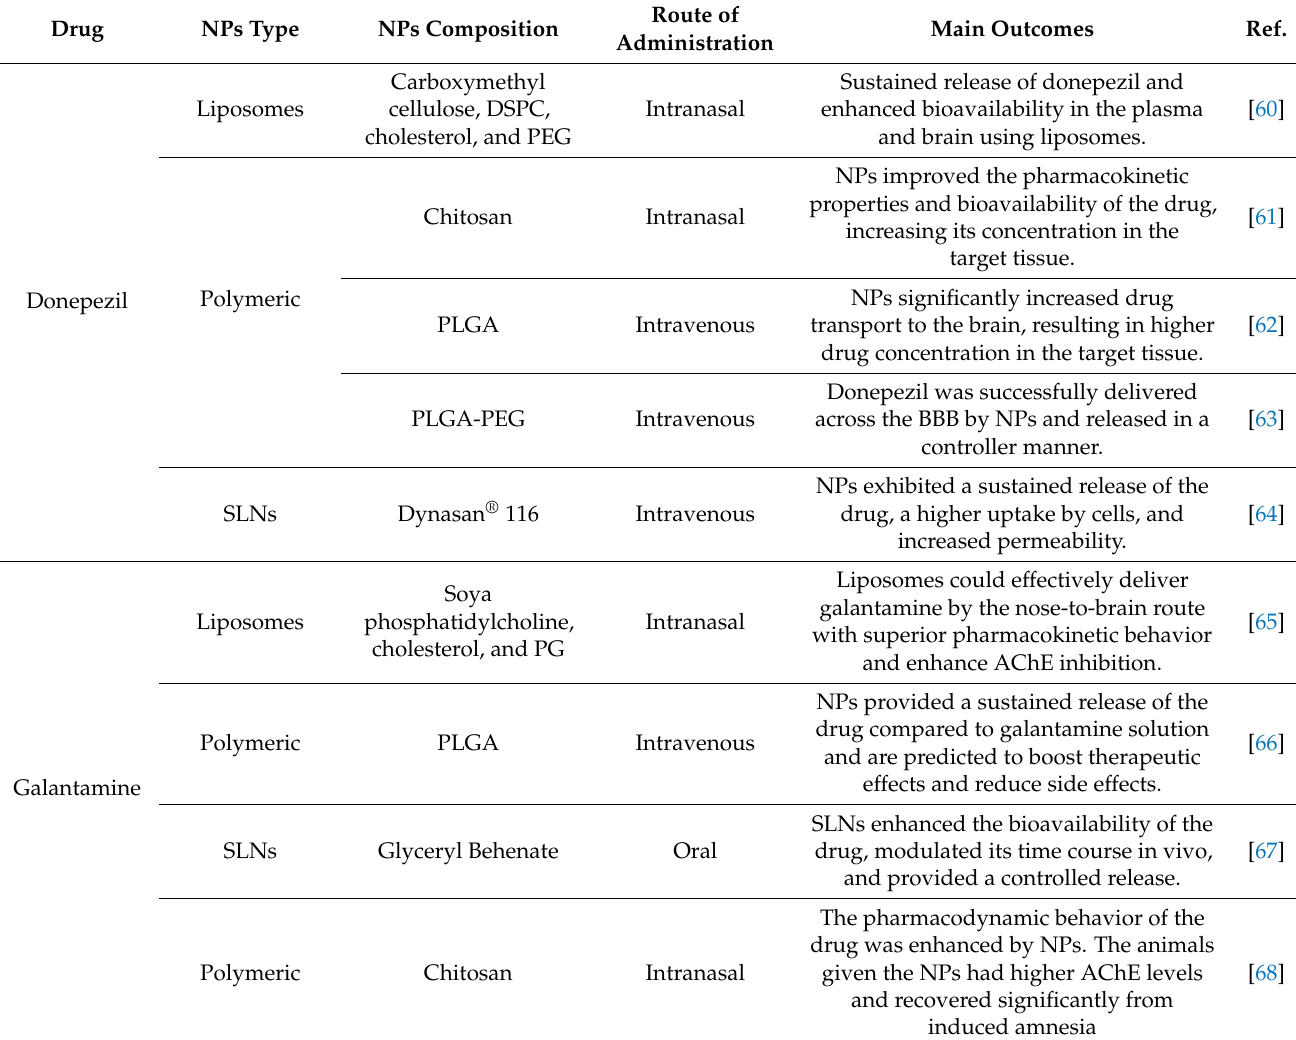
The most recent applications of NPs as DDSs for delivering FDA-approved Alzheimer’s